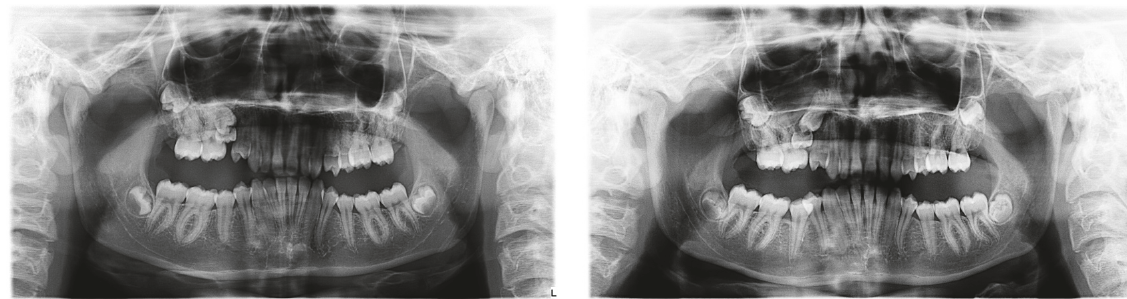
Figure 2: Panoramic radiographs of the identical